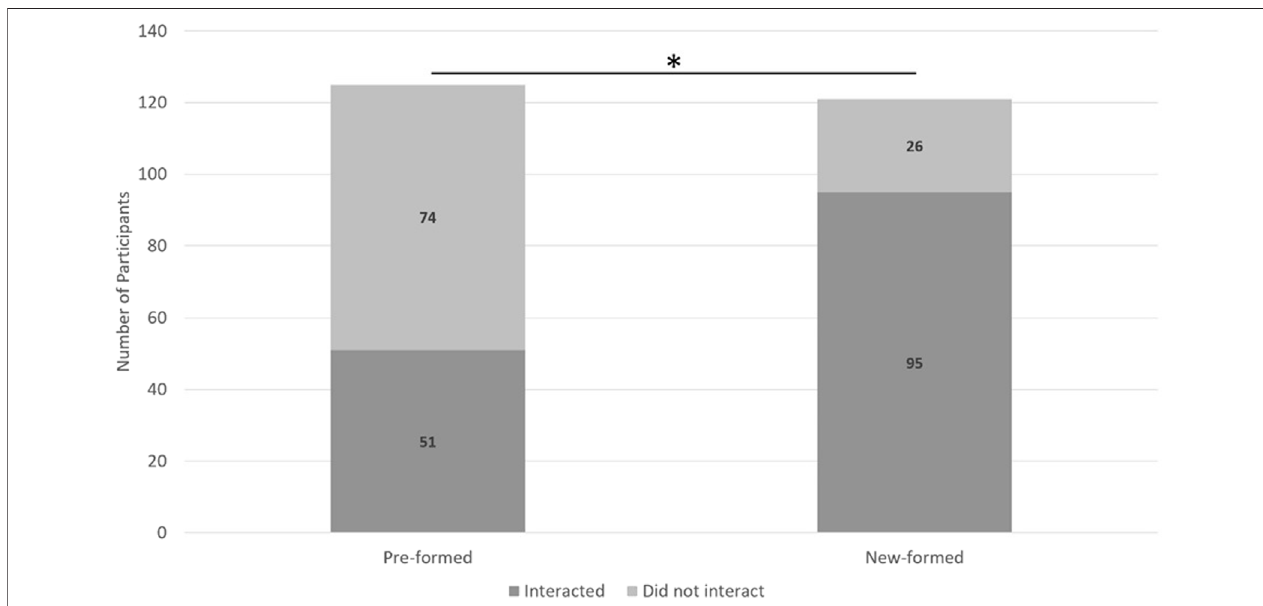
FIGURE 2 | A description of the results from H2a. Asterisks indicate new-formed groups were more likely to verbally interact than pre-formed groups.